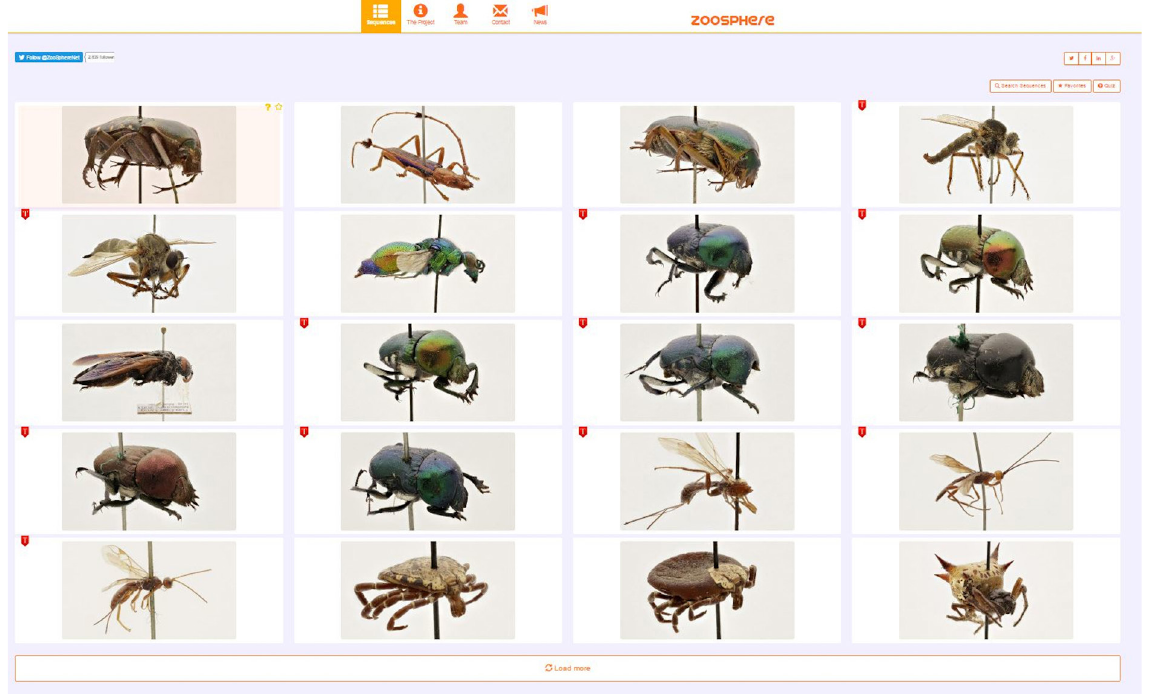
Fig. 2.20. Overview of the digitised specimen with the ZooSphere setup, visible at Zoosphere.net. Image copyright